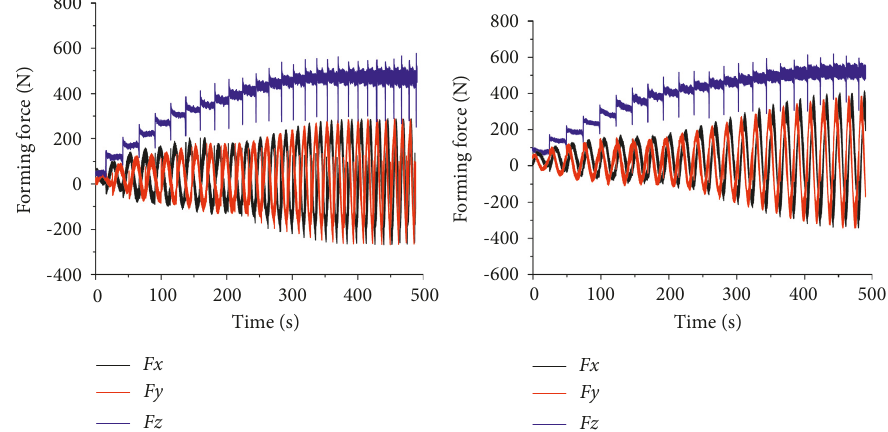
Figure 12: Forming force simulated in forming part experiment: (a) 1# formed part and (b) 45# formed part.